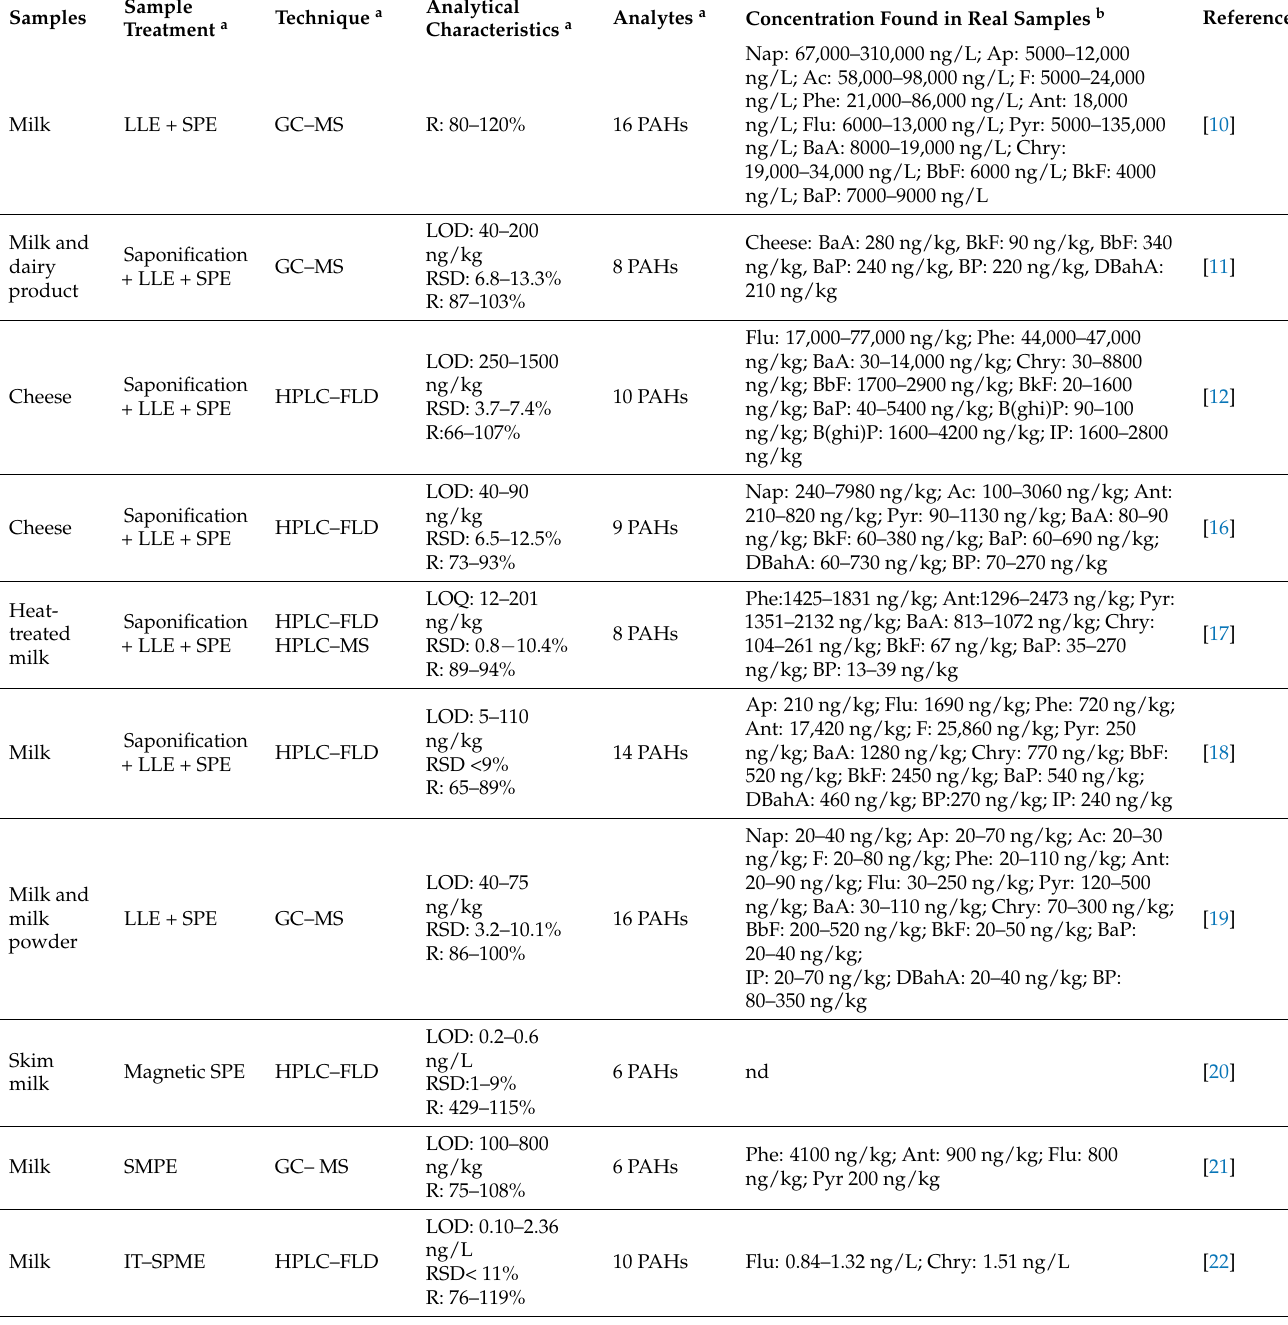
Table 1. Selected studies for the presence of PAHs in milk and dairy